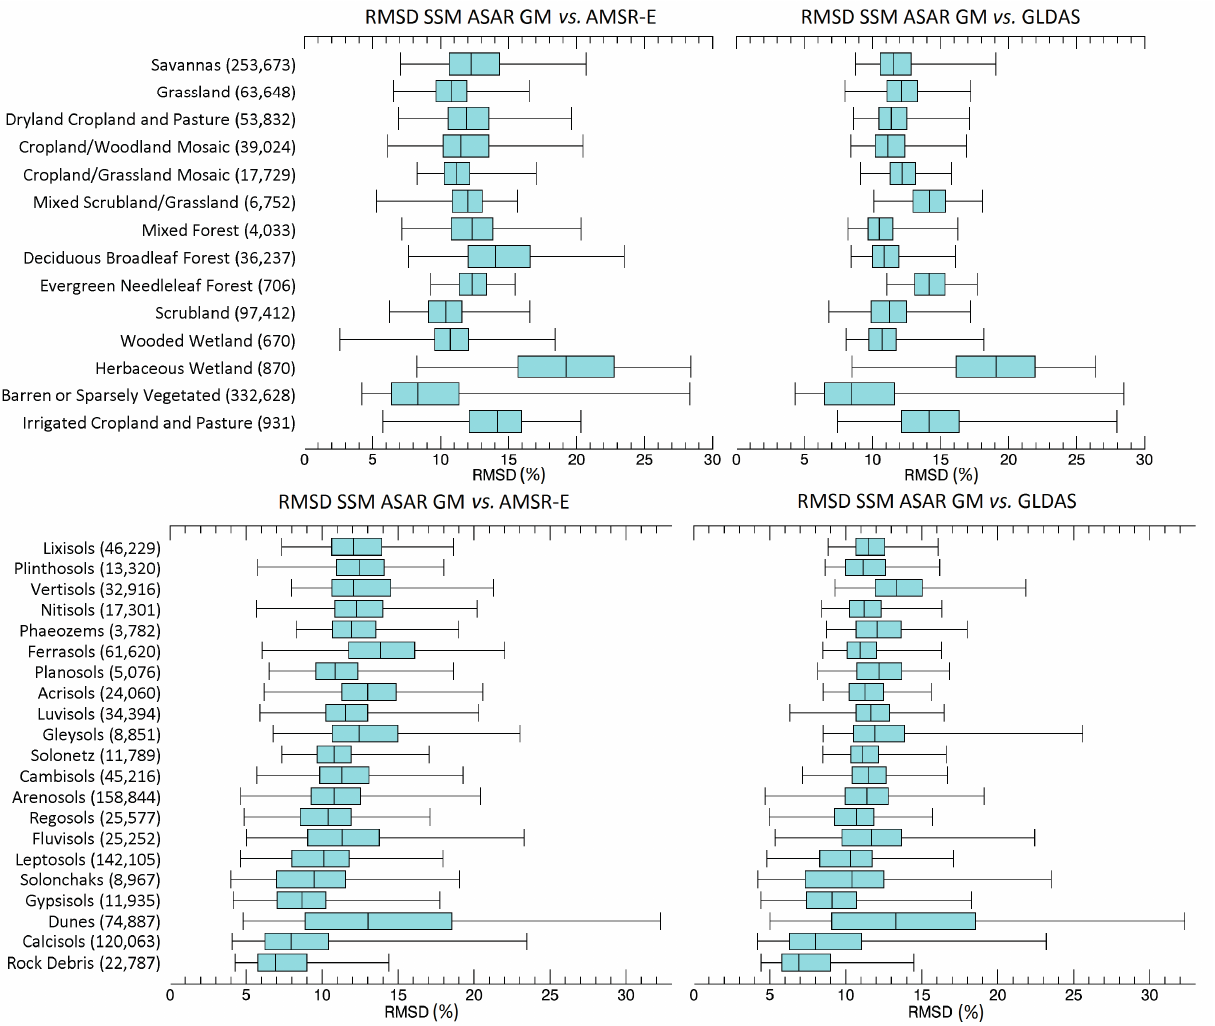
Figure 11. The box-plot representation of the root mean square difference (RMSD) results stratified by the Land Use/Land Cover system from U.S. Geological Survey Global Land Cover Characteristics ( Top ) and Harmonized World Soil Database soil types ( Bottom ). The boxes show the median, 25th and 75th percentiles; the lines represent minimum and maximum values after outlier removal (first and 99th percentile). The amount of 5-km Advanced Synthetic Aperture Radar (ASAR) pixels used for the evaluation for each class is shown in brackets behind the class name. ( Left ) ASAR Global Monitoring (GM) mode vs. Advanced Microwave Scanning Radiometer for Earth Observing System (AMSR-E) Surface Soil Moisture (SSM); ( Right ) ASAR GM vs. the Noah model from the Global Land Data Assimilation System (GLDAS-NOAH)